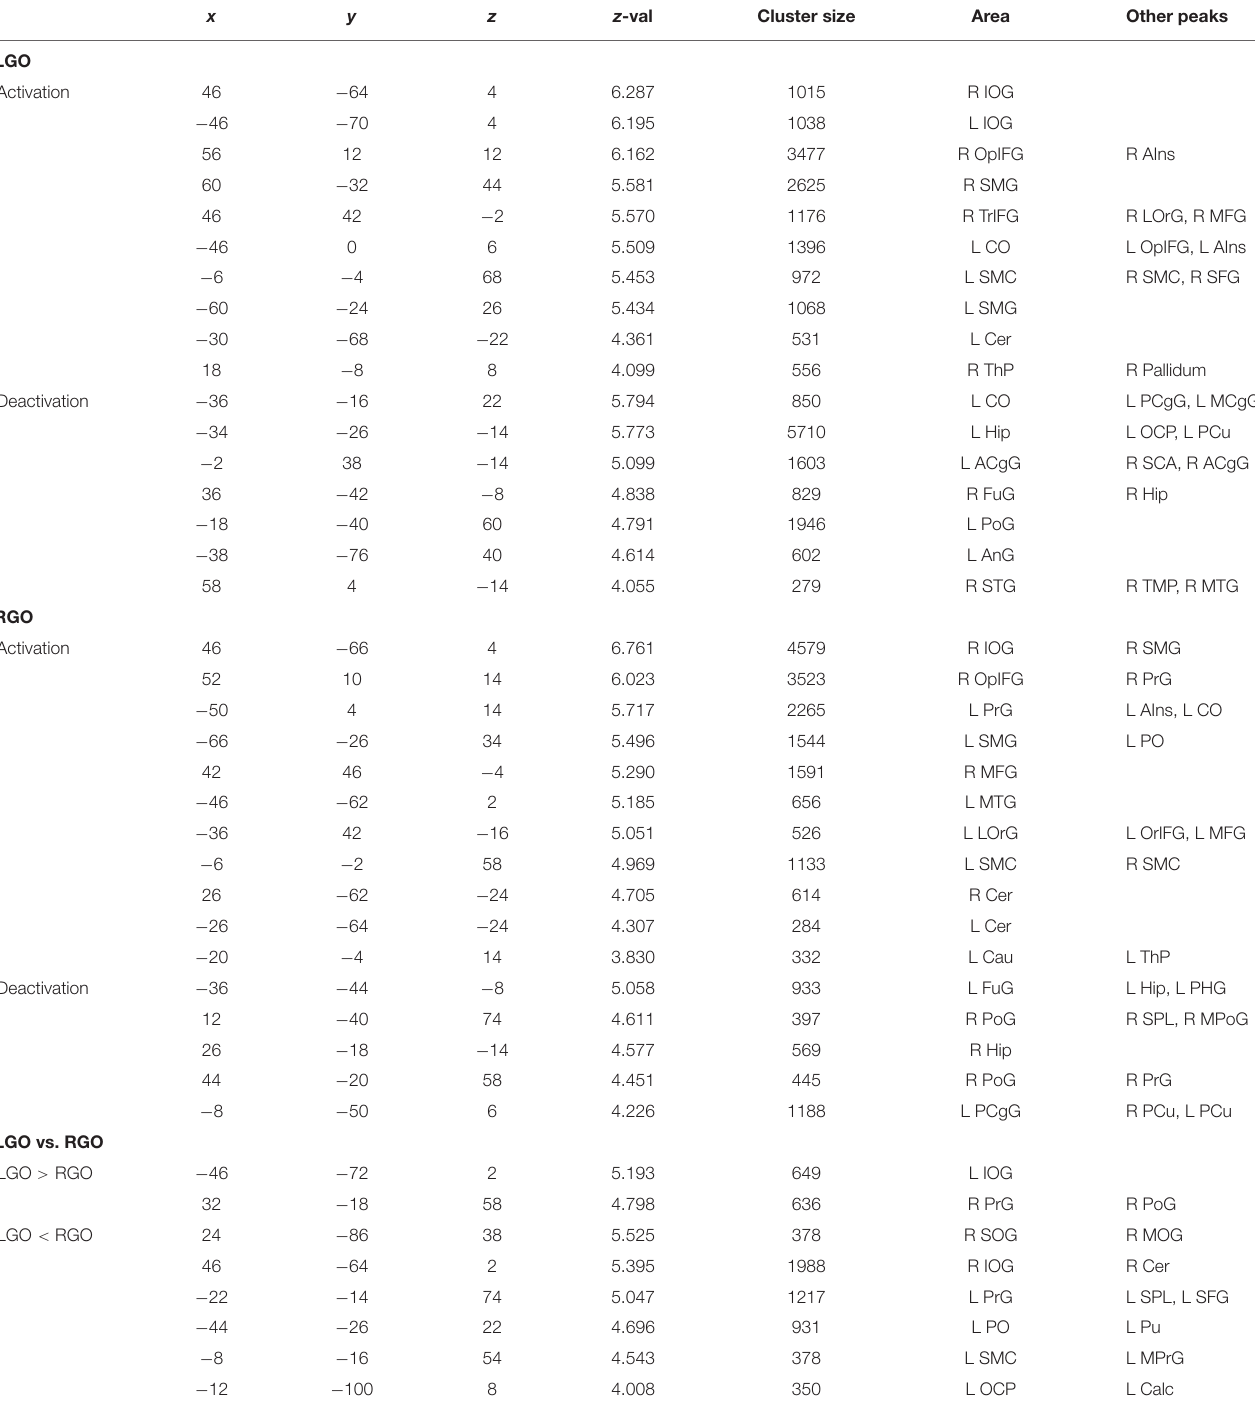
TABLE 3 | Clusters showing significant (FWEc p < 0.05) activation and deactivation during feedback run 2 for the different motor imagery tasks. x y z z -val Cluster size Area Other peaks LGO